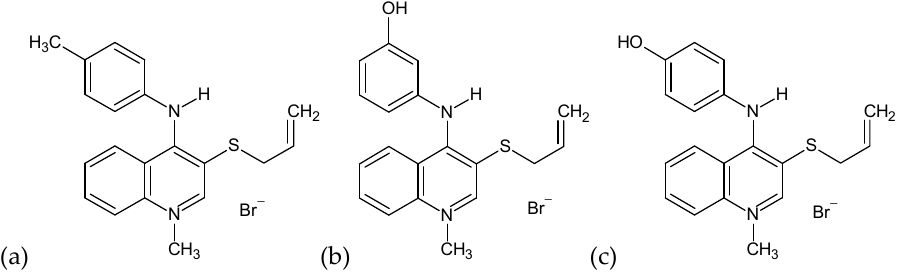
Figure 3. Structural formula of Qui1 ( a ), Qui2 ( b ) and Qui3 ( c ) (ChemSketch 12.1.0.31258).